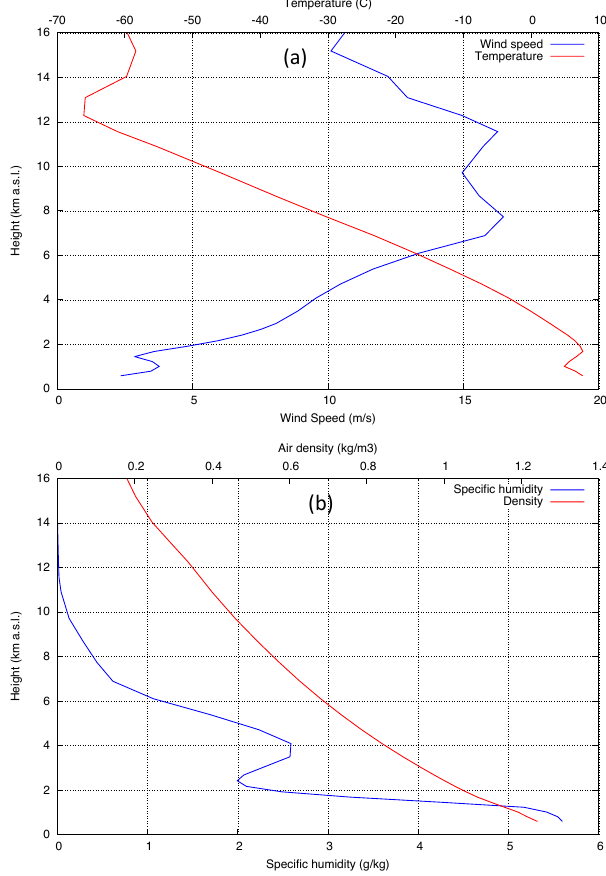
Figure 9. Atmospheric profiles extracted form ERA-Interim re- analysis data set at Eyjafjallajökull vent location for 6 May 2010 at 12:00UTC. (a) : wind and temperature profiles. (b) : specific hu- midity and air density